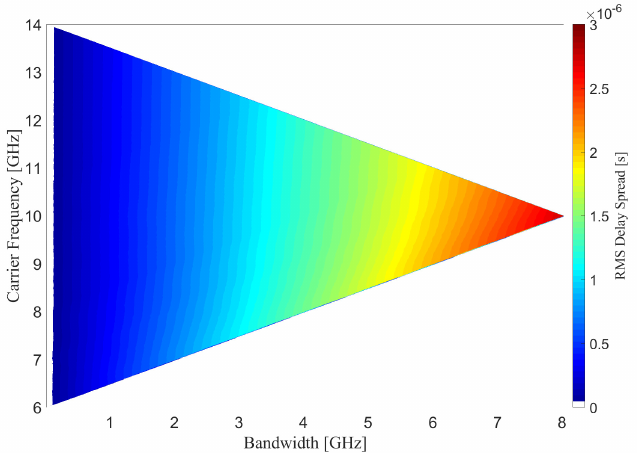
Figure 9. The RMS delay spread versus carrier frequency and bandwidth at Position